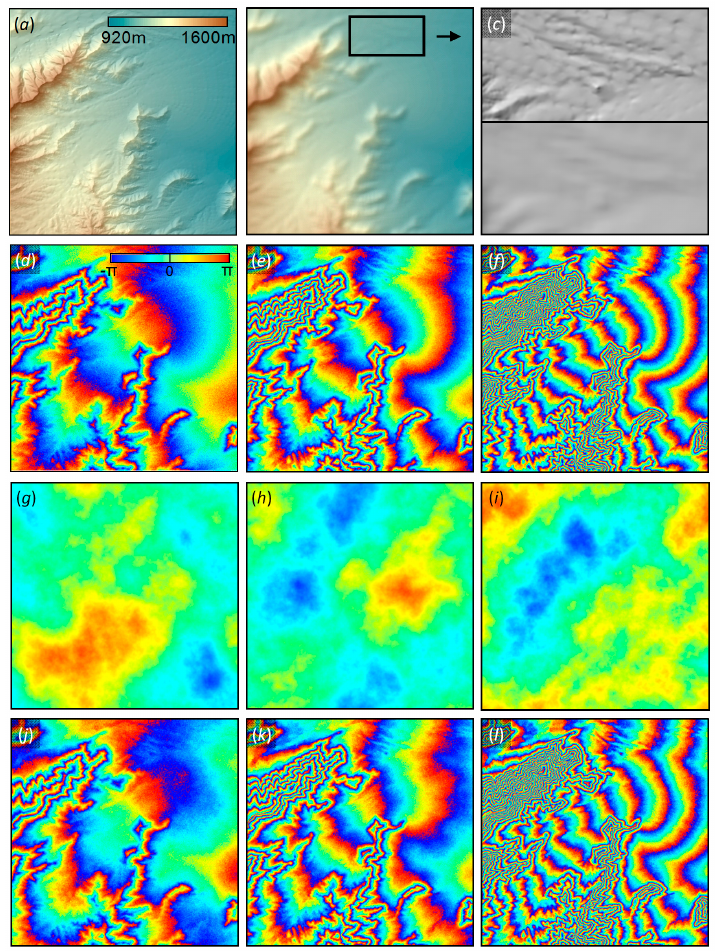
Figure 3. ( a ) Hillshade of 10 m NED DEM; ( b ) hillshade of 15 × 15 smoothing filtered NED DEM; ( c